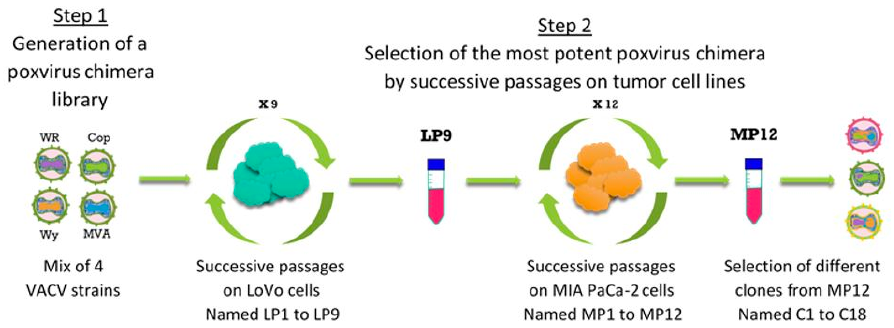
Figure 1. The directed evolution process. Representation of the different steps of the directed evolution process used to select a new Poxvirus chimera with improved oncolytic activity.